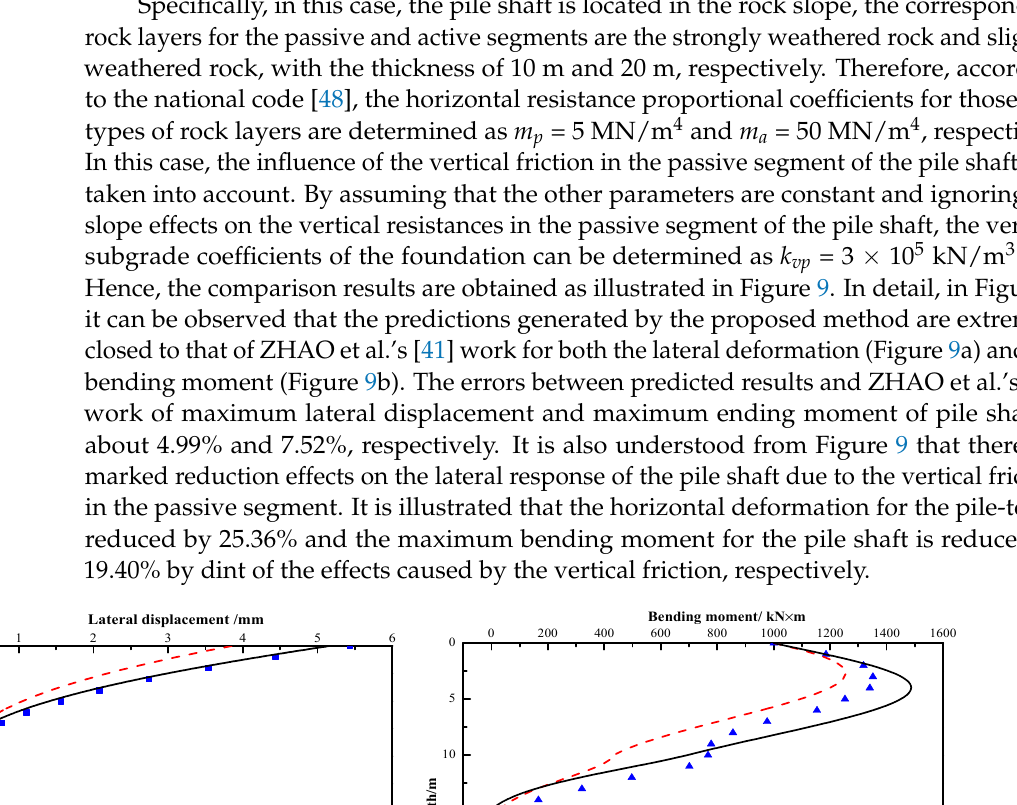
Table 2. Detailed parameters in work of ZHAO et al. [41].